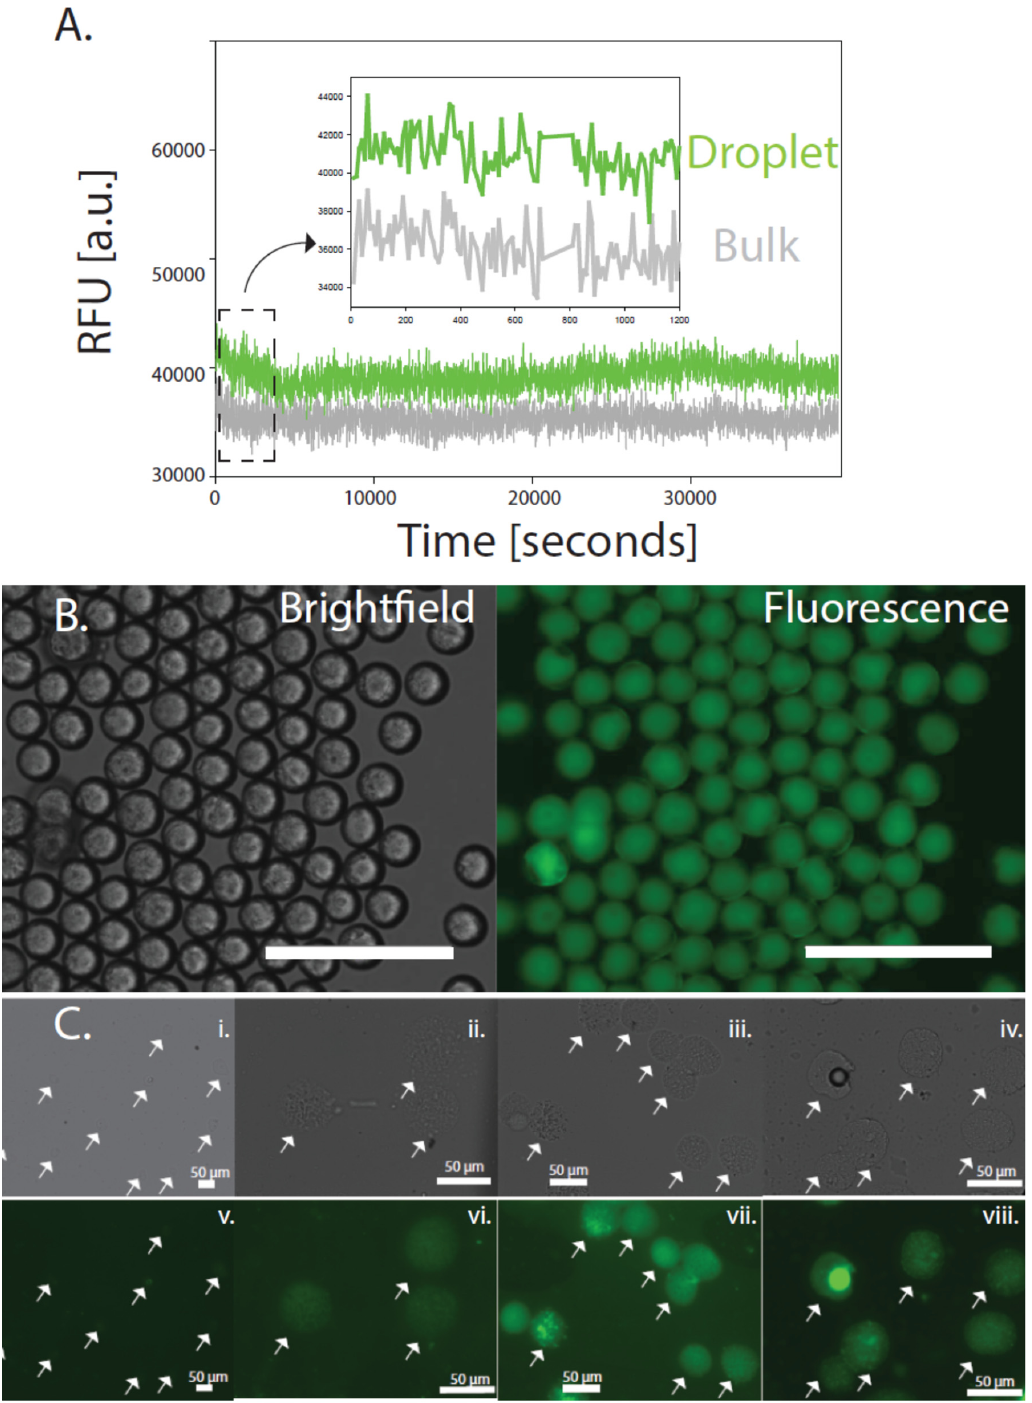
Figure 3. Agarose TXTL bead based sensing and quantification using the LasR-mechanism ( A ). The signal intensity differences observed between agarose bead versus bulk sensing ( B ). Brightfield and Fluorescence images of the agarose TXTL beads (scale bar = 1 mm) ( C ). Various concentrations of HSL (from 100 nM stock) added to the agarose beads to demonstrate HSL sensitivity in the LasR-based quorum-sensing system and subsequent fluorescence signal ( i , ii , iii , iv ) represent the brightfield image of the agarose beads and ( v , vi , vii , viii ) the corresponding fluorescent image, respectively. ( i ) 0 nM, ( ii ) 10 nM, ( iii ) 30 nM, ( iv ) 50 nM. The white arrows are showing the droplets under varying conditions of brightfield and fluorescence detection as a function of increased HSL (scale bar = 50 mm).